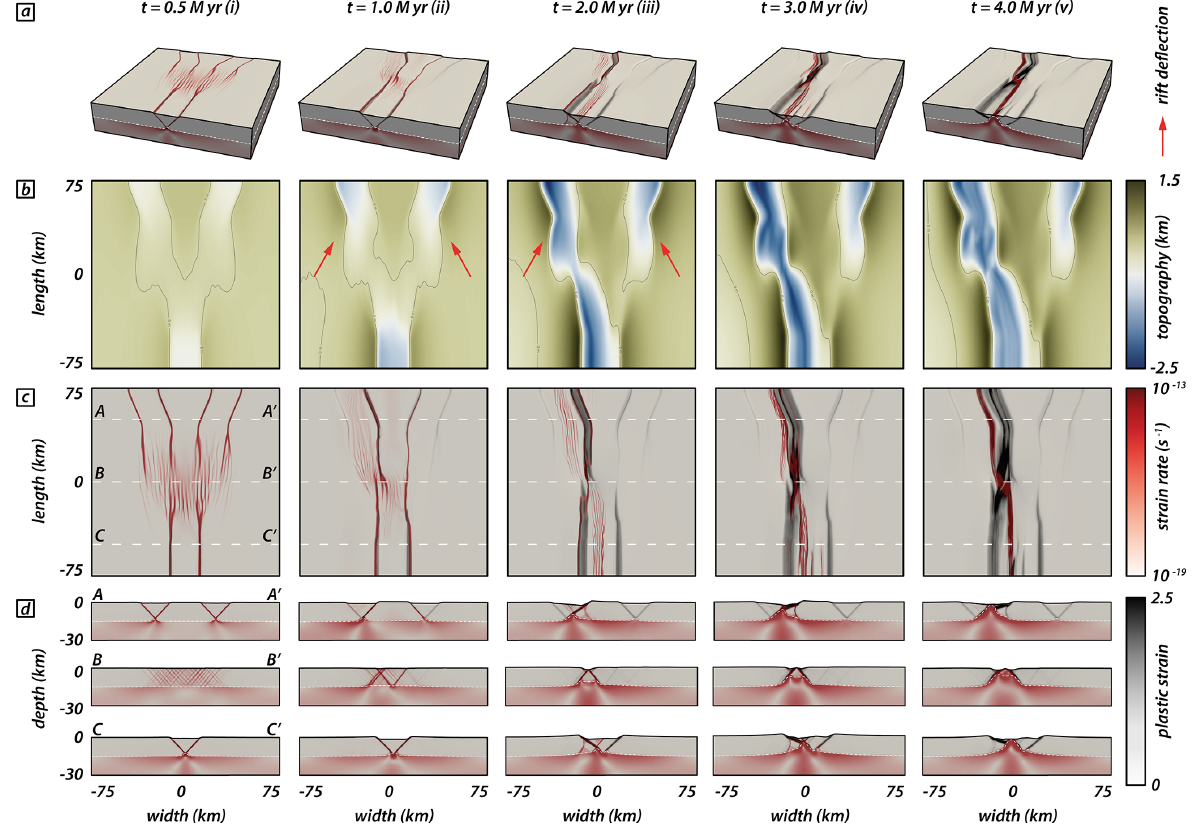
Figure 5. Modeling results of the reference model documenting cessation of fault activity along the right rear segment, while the left rear and frontal segments link. Distinct time steps show the model evolution. (a) Model box showing logarithmic strain rates (red) and plastic strain (black) in the brittle and viscous model domain. White dashed lines indicate the brittle–viscous interface. (b) Top views showing the model topography. Red arrows indicate rift tips that deflect and turn away from one another. Black lines refer to the zero-elevation height. Color map from Crameri et al. (2020). (c) Top views of the model showing strain rates (red) and corresponding plastic strain (black) at distinct model run times. White dashed lines correspond to the three rift transects A-A (cid:48) , B-B (cid:48) , and C-C (cid:48) in panel (d) . (d) Rift axis perpendicular transects A-A (cid:48) , B-B (cid:48) , and C-C (cid:48) parallel to the extension